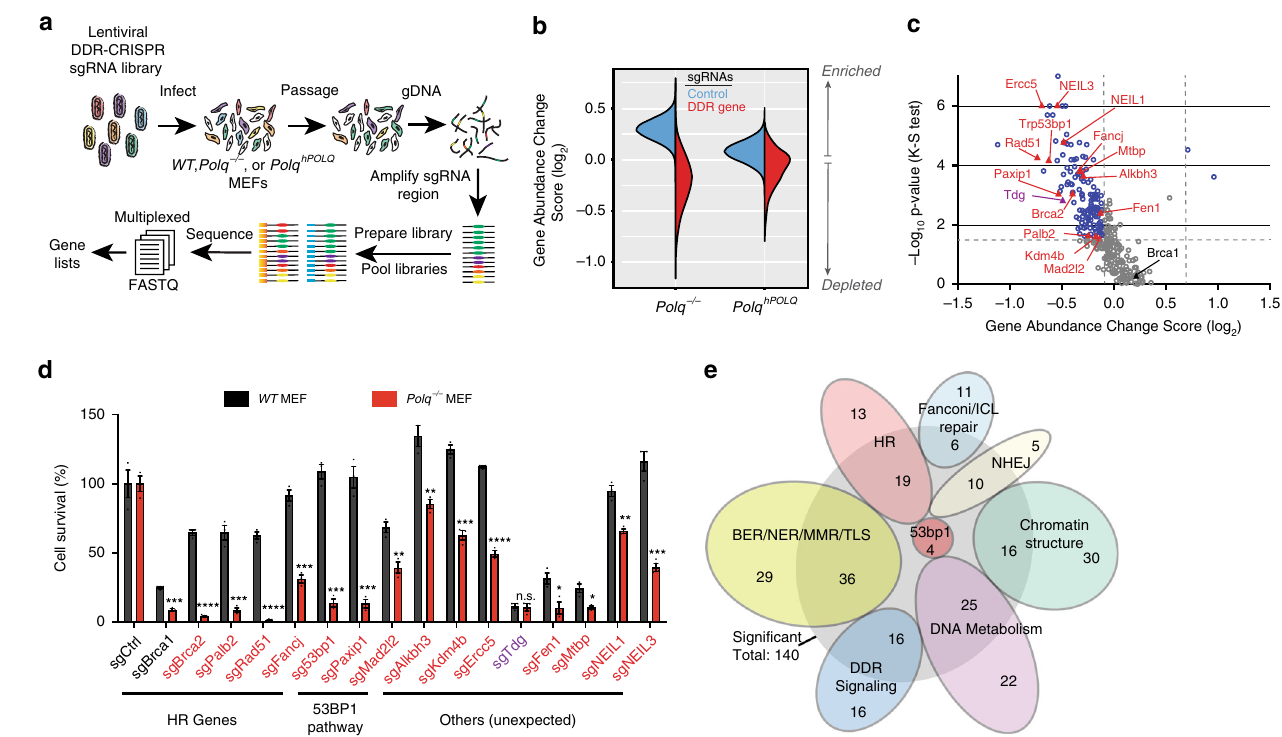
Fig. 1 Identi fi cation of Polq synthetic lethal (PolqSL) genes by CRISPR screening. a Schematic of the CRISPR genetic screen to identify PolqSL genes. b Violin plot of Gene Abundance Change Scores (Log 2 ) for DDR gene-targeting sgRNAs (red) and non-targeting control sgRNAs (blue) in Polq − / − and Polq hPOLQ MEFs, relative to WT MEFs. c Volcano plot of Gene Abundance Change Scores ( Polq − / − versus Polq hPOLQ ) and -Log 10 p-value of the Kolmogorov-Smirnov test for DDR gene-targeting sgRNAs relative to non-targeting control sgRNAs. Thresholds for statistical signi fi cance are indicated by dashed lines (see “ Methods ” for details). Genes with statistically signi fi cant (Blue dots) and non-signi fi cant (Gray dots) Gene Abundance Changes Scores are indicated. Genes with red/purple triangles are further validated in Fig. 1d. d Relative cell survival measured by colony forming ef fi ciency of WT or Polq − / − cells transduced with a lentivirus containing Cas9 and control sgRNA (sgCtrl) or DDR gene-targeting sgRNAs. Data shown are the mean ± SEM ( n = 3 biological replicates). Signi fi cance determined using an unpaired, two-tailed t-test (* p < 0.05; ** p < 0.01; *** p < 0.001, **** p < 0.0001). e Functional classi fi cation of PolqSL genes identi fi ed in our CRISPR screen depicted as a Euler